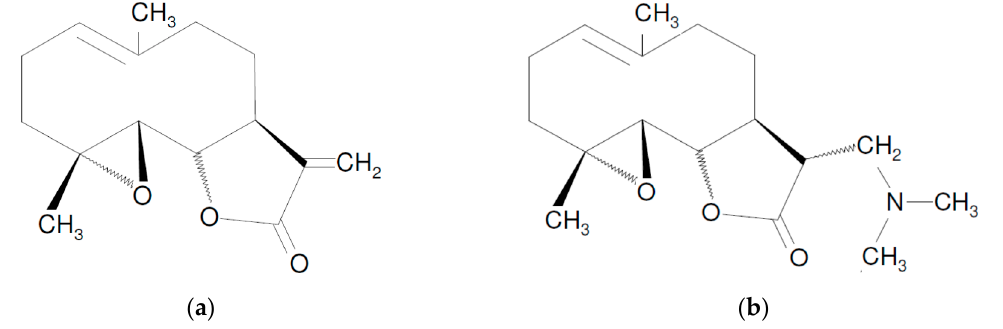
Figure 1. Chemical structure of parthenolide (PN), ( a ) a sesquiterpene lactone from Tanacetum Figure 1. ( a ) Chemical structure of parthenolide (PN), a sesquiterpene lactone from Tanacetum parthenium, and dimethylamino ‐ parthenolide (DMAPT), ( b ) a synthetic, water ‐ soluble derivative of parthenium, and ( b ) Chemical structure of dimethylamino-parthenolide (DMAPT), a synthetic, water-soluble derivative of PN.